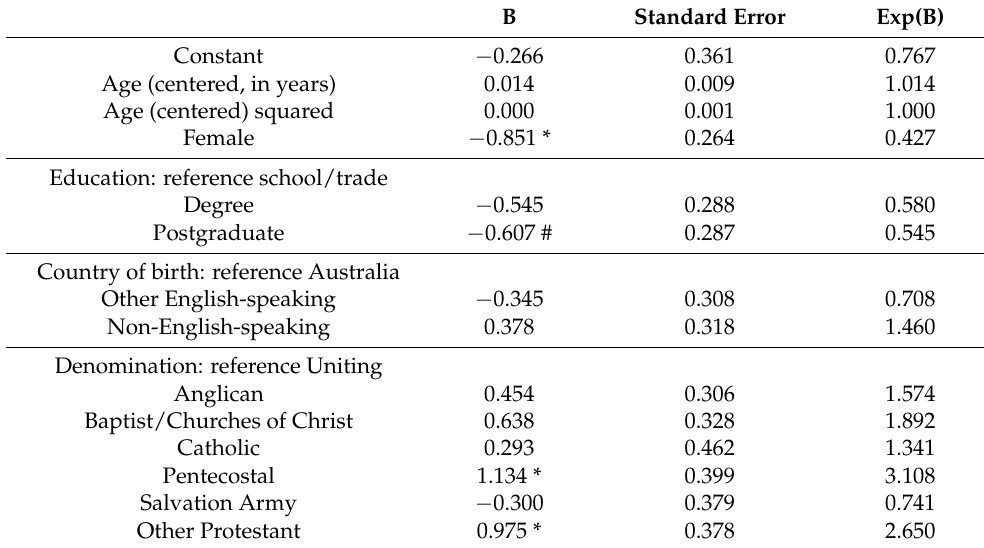
Table 6. Prediction of marriage/couples counselling from demographics and